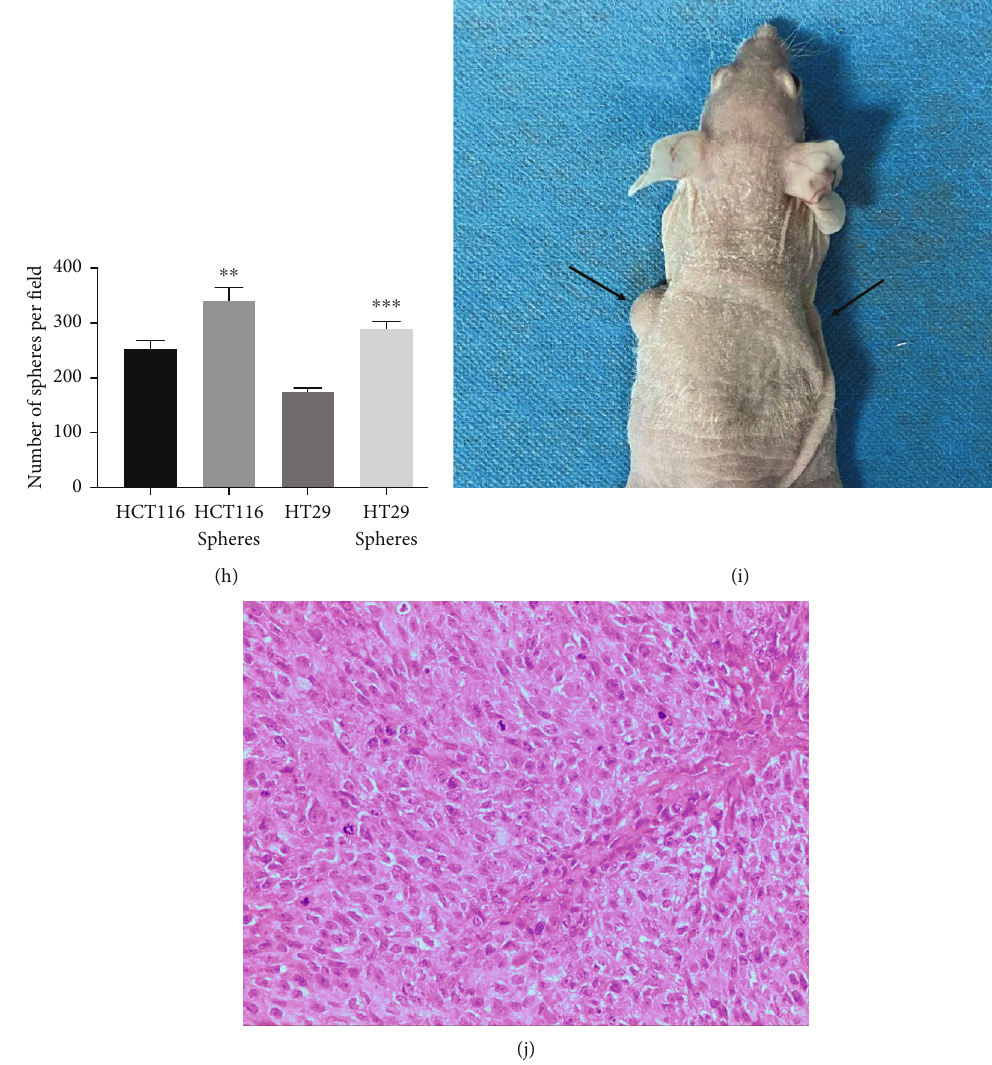
Figure 1: Sphere cells derived from HCT116 and HT29 cell lines display CSC characteristics. (a) HCT116 and HT29 were cultured in serum-free medium for 14 days to obtain spheres. (b) The SFE of sphere cells from the fi rst to fi fth passage. (c, d) The expression of Oct4, Nanog, CD133, and CD44 by performing the Western blot in total protein. (e, f) The ratio of Aldh+ cells was analyzed by fl ow cytometry assay. (g, h) Transwell assay in fi fth-passage sphere cells and the parental cells; the histogram shows the number of migrated cells per fi eld. (i) Representative pictures showing the tumorigenic capacity of 10 4 fi fth-passage CRC sphere cells and 10 4 parental cells. (j) HE staining of tumor xenografts from the fi fth-passage sphere cells. ∗ P < 0 : 05 , ∗∗ P < 0 : 01 , and ∗∗∗ P < 0 : 001 vs. the parental Table 1: Tumor formation of HCT116 fi fth-passage sphere cells and parental cells.